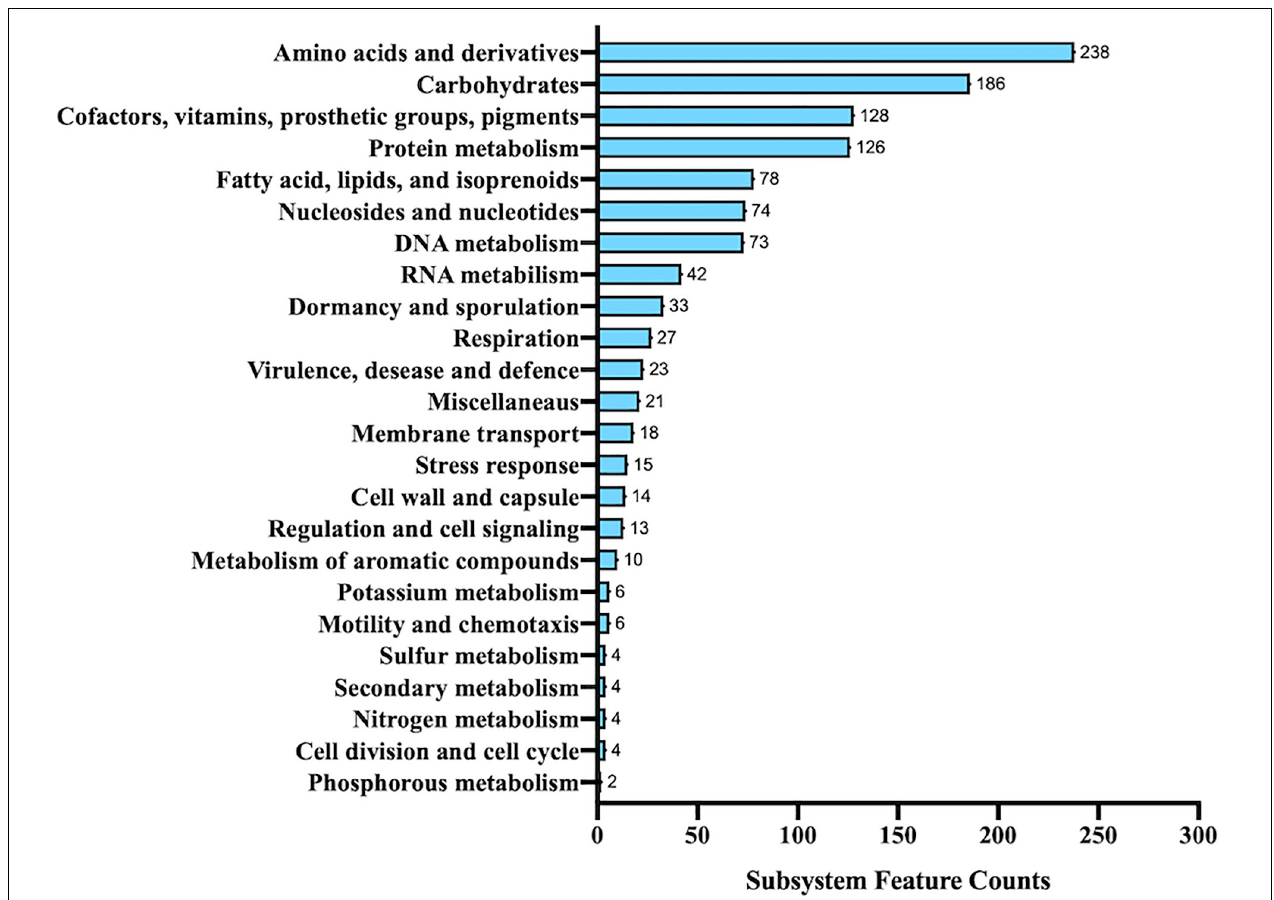
FIGURE 3 | Functional annotation of Alicyclobacillus isolate using RAST server.